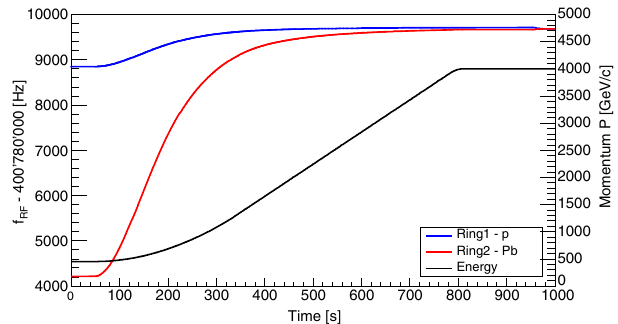
FIG. 9. Evolution of the proton and lead ion rf frequencies during an energy ramp to 4 TeV = c. The frequencies are locked together at 4 TeV = c (around time 960).